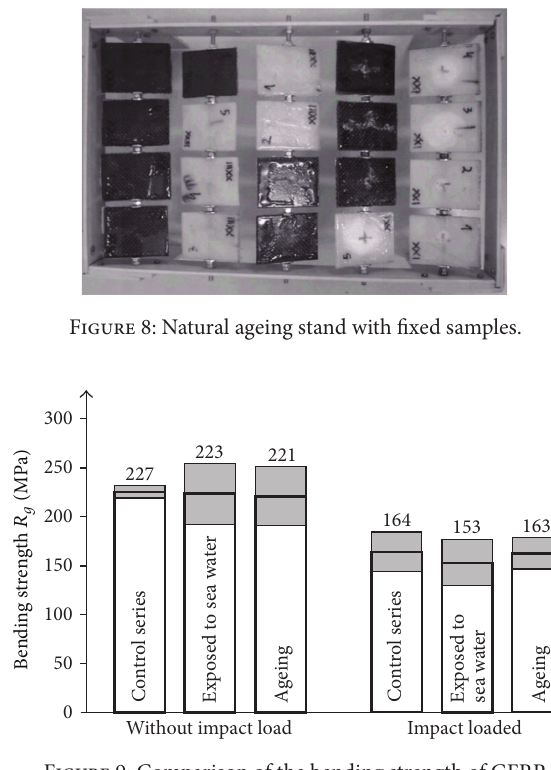
Figure 9: Comparison of the bending strength of GFRP.